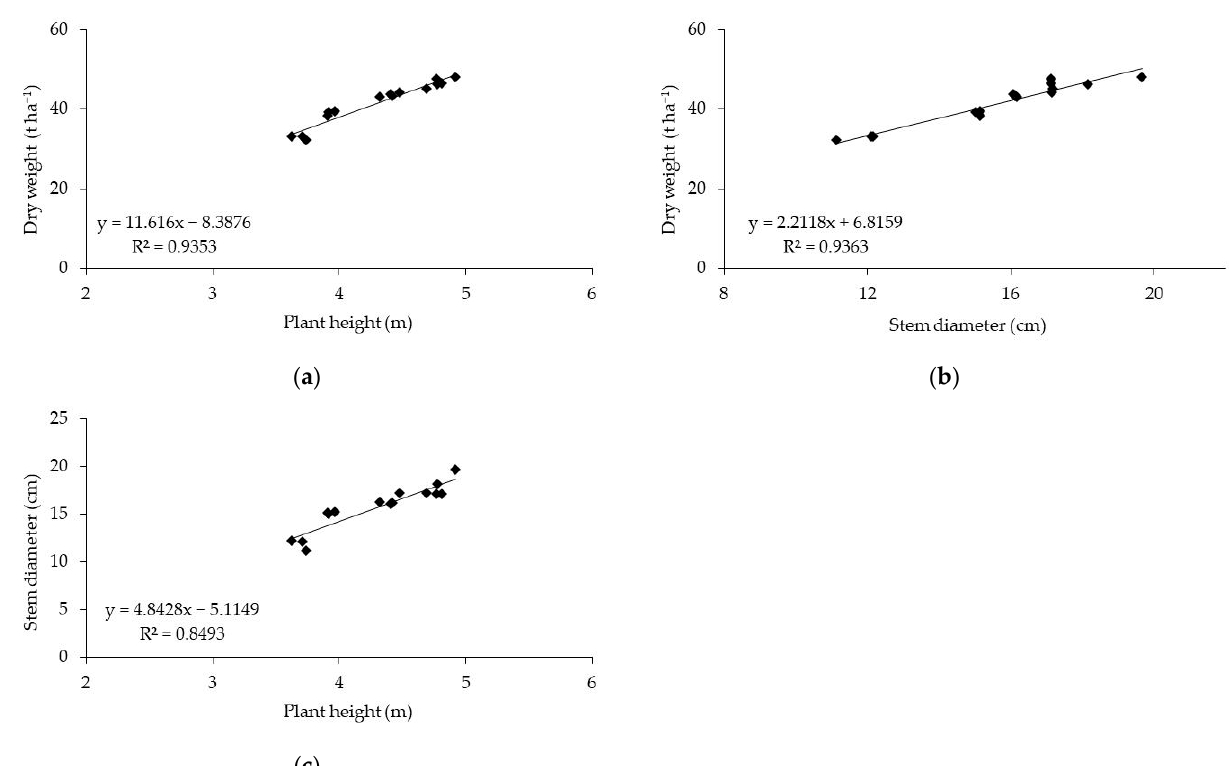
Figure 4. Relationships between morphological and production characteristics taking into consideration giant reed plants irrigated with TWW 1 . ( a ) Refers to relationship between plant height and above-ground dry weight; ( b ) refers to relationship between stem diameter and above-ground dry weight; and ( c ) refers to relationship between plant height and stem diameter.